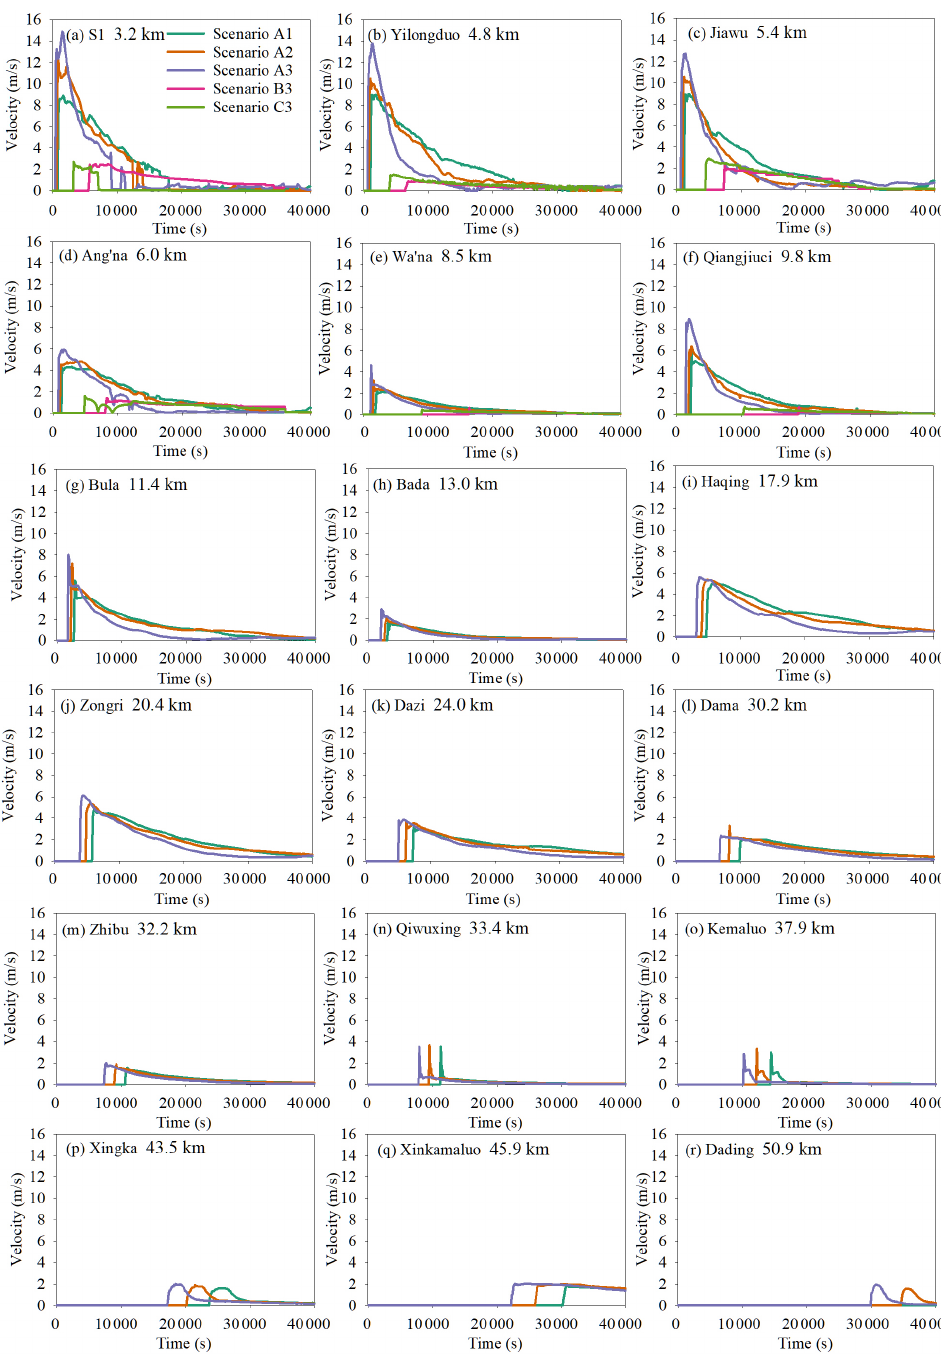
Figure 14. Time series of velocity at different settlements along the flow channel (locations in Fig. 1) of different